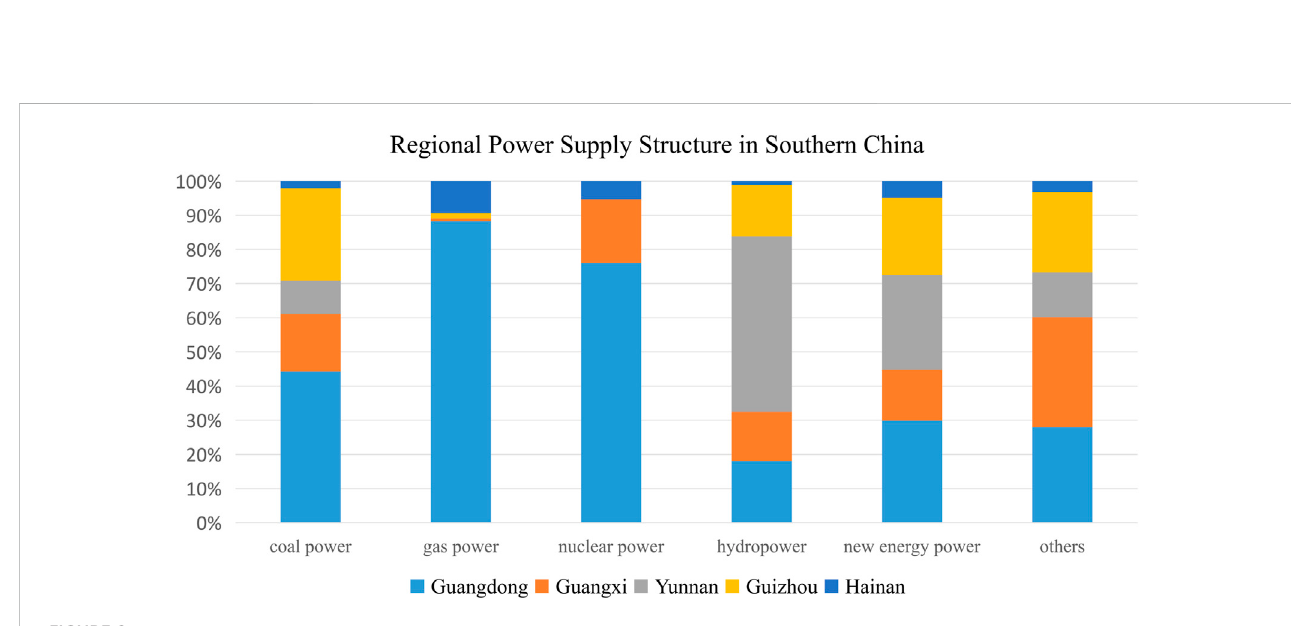
FIGURE 2 Regional power supply structure in southern